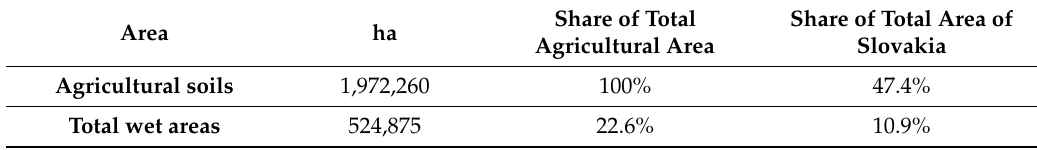
Table 4. Share of wet areas in agricultural soils in